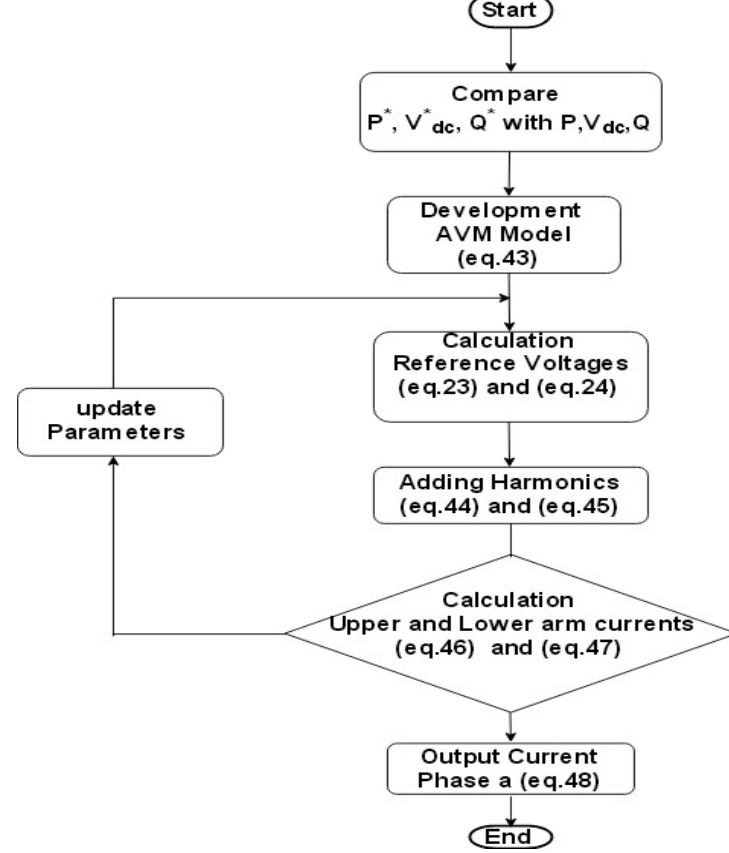
Figure 4. Flowchart of proposed direct modulation.